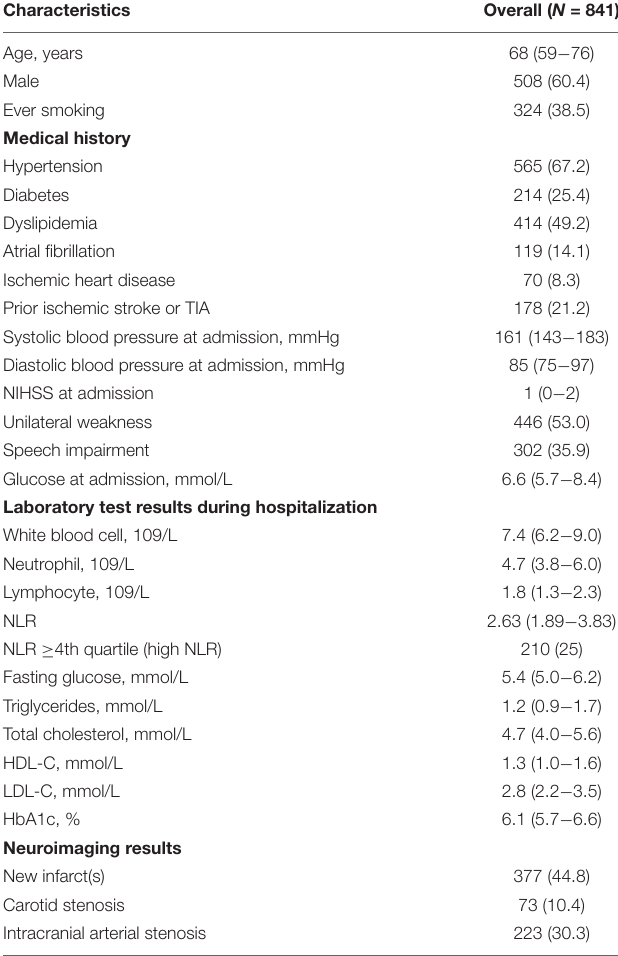
TABLE 1 | Characteristics of the patients at